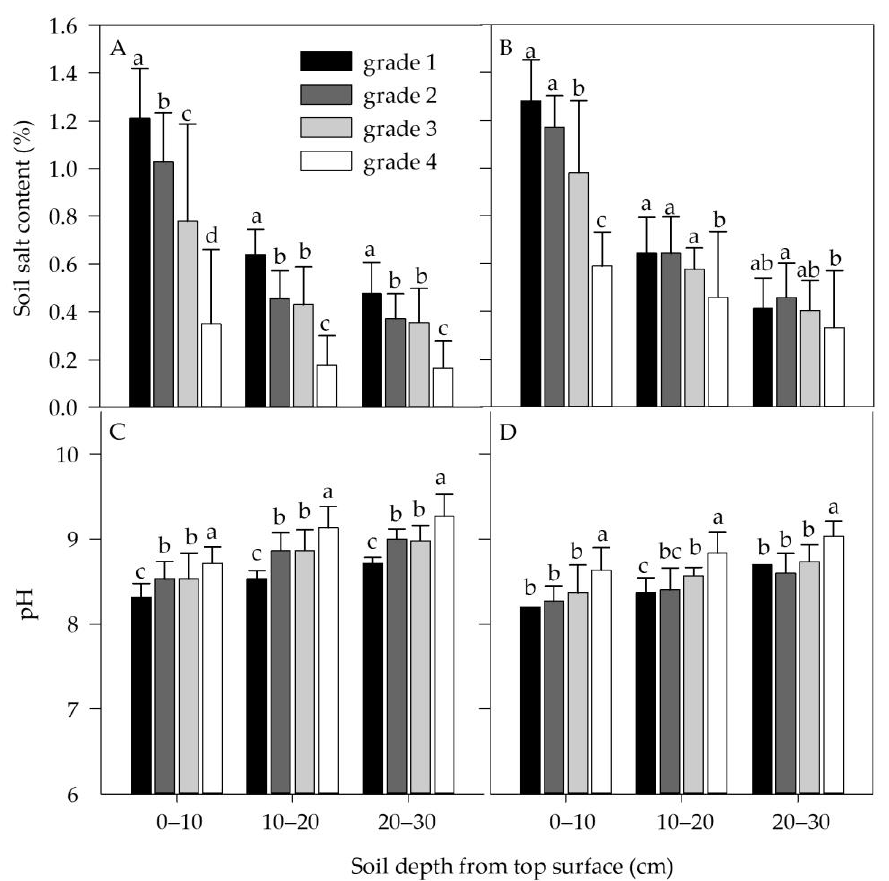
Figure 1. Photograph and survival rate of tall wheatgrass seedlings grown in saline-alkaline soils with different salinities. ( A – D ) Photographs of seedlings in grades 1 – 4; and ( E ) the survival rate of four seedling grades. Photographed on 11 April 2022, in Dongying, China. Data were represented as mean ± SD. Different letters indicate a significant difference at p < 0.05.